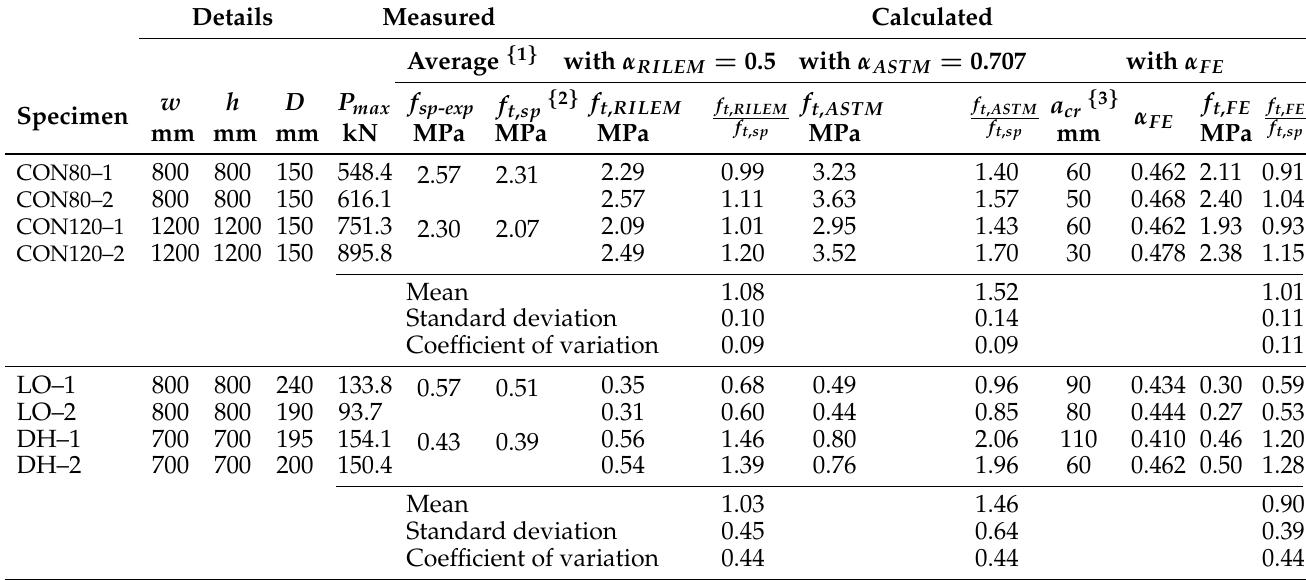
Table 9. Diagonal compression tests—specimens’ details and